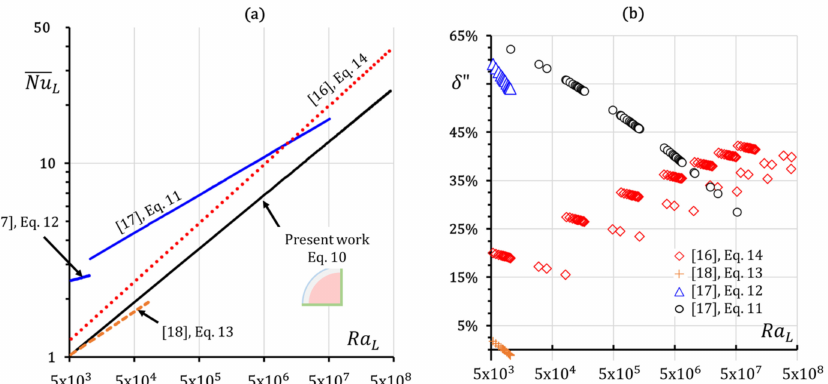
Figure 8. Comparison with other work dealing with whole concentric spheres ( a ) Average Nusselt number ( b )